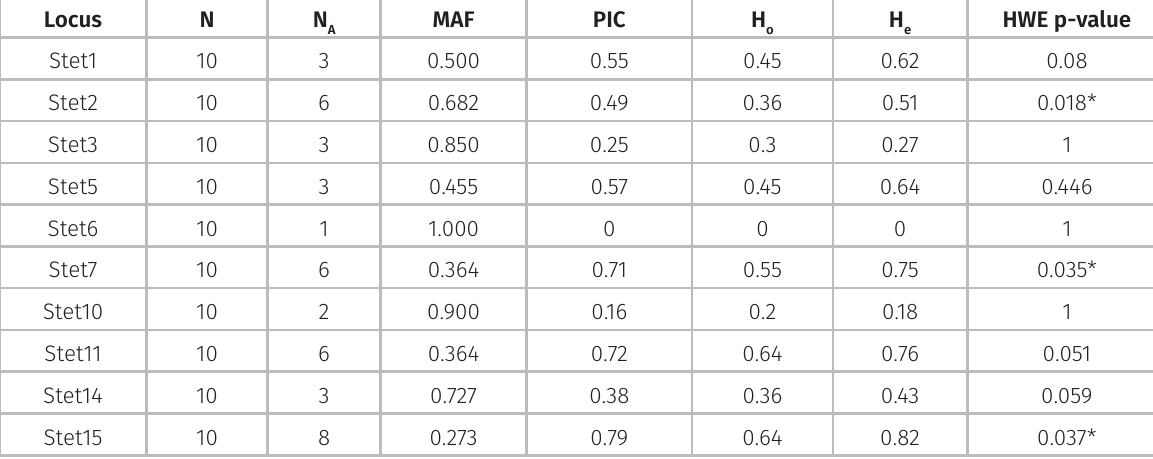
Table III. Microsatellite loci analyzed on 10 individuals from two evaluated populations of S. coryne.